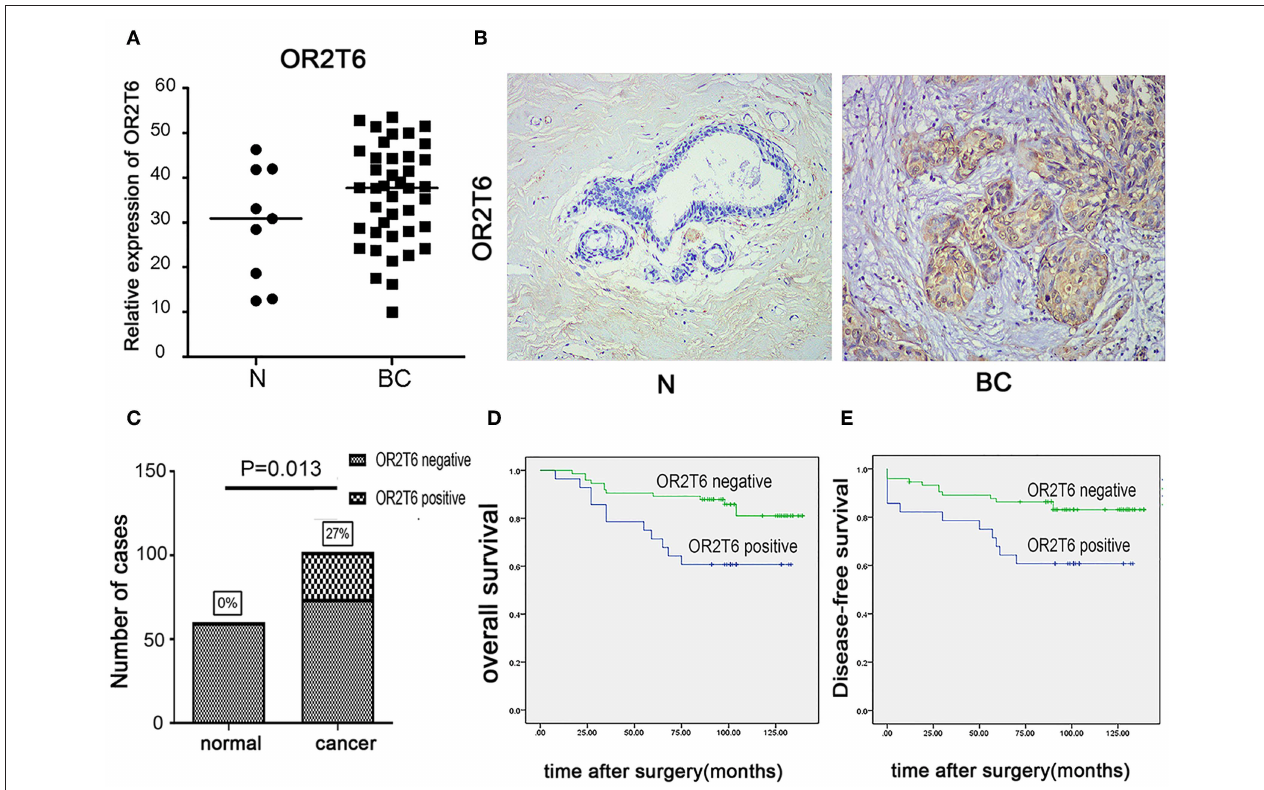
FIGURE 1 | OR2T6 expression in breast cancer tissues and its association with patients’ outcome. (A) The mRNA levels of OR2T6 in normal breast tissues ( n = 9 samples) and breast cancer tissues ( n = 41 samples) were assessed by the method of real-time quantitative PCR. Chi-square test was used to analyze the difference between the two groups. (B) Representative immunohistochemistry staining of OR2T6 protein in normal breast tissues ( n = 60 samples) and breast cancer tissues ( n = 102 samples) (H&E magnification, 40 × ). OR2T6 protein located in the cytoplasm. “BC” stands for breast cancer; “N” stands for normal breast epithelium. (C) Chi-square test revealed that OR2T6 expression was significantly higher in breast cancer tissues than in normal tissues. (D,E) Survival was analyzed by the Kaplan–Meier method and compared by log-rank tests. Kaplan-Meier curves for survival of 102 patients with breast cancer by OR2T6 positivity and negativity. Culminative overall survival (D) and disease-free survival (E)